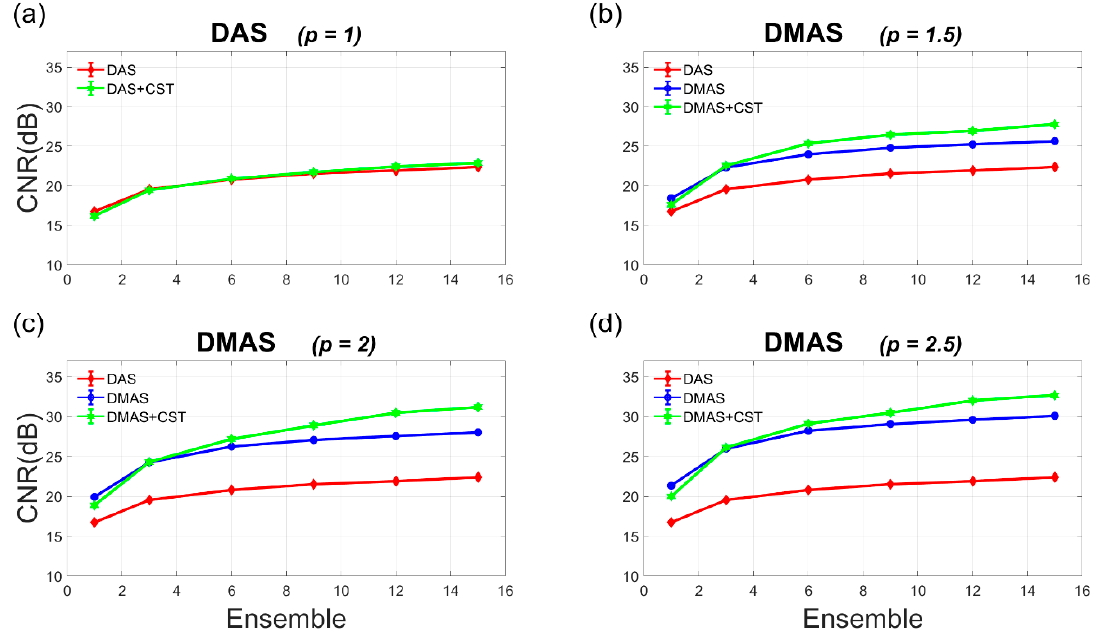
Figure 6. Quantitative analysis of Doppler CNR in the simulations as a function of ensemble number for ( a ) DAS beam- forming and ( b – d ) DMAS beamforming with the p value of 1.5, 2.0, and 2.5, respectively.